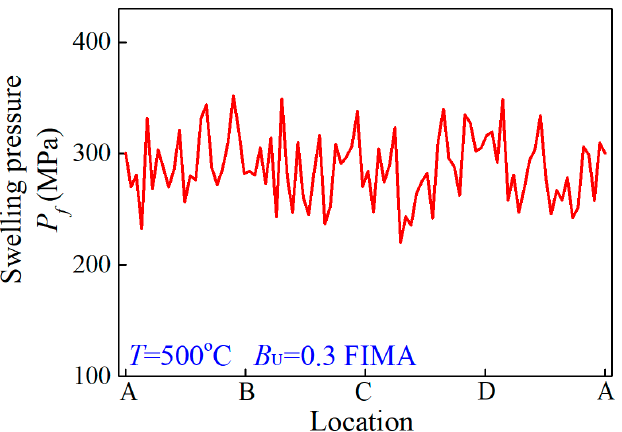
Figure 7. The swelling pressure on matrix interface Γ at dangerous conditions of 500 °C and 0.3 FIMA.